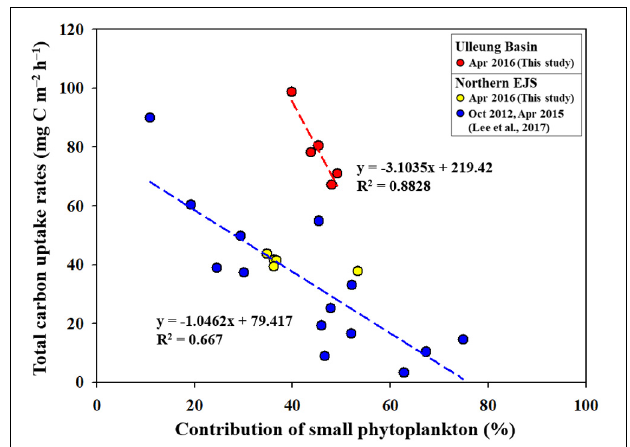
FIGURE 9 | Relationships between productivity contributions of small phytoplankton and the total primary productions in the UB and northern EJS.